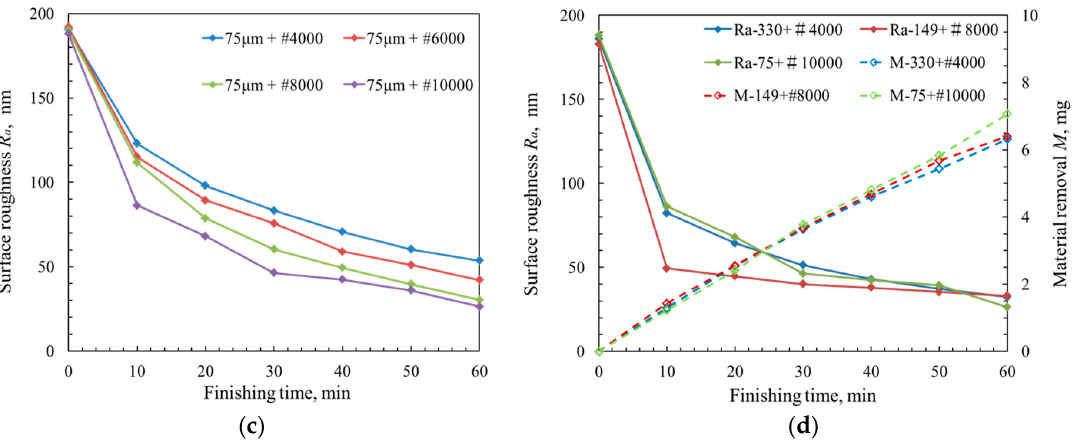
Figure 5. Change in surface roughness R a under the conditions of iron powder with different diameters mixed with different sizes of WA abrasive; comparison of the best experimental results under the conditions of iron powder with different diameters: ( a ) iron powder with a mean diameter of 330 μ m mixed with different sizes of abrasive grains; ( b ) iron powder with a mean diameter of 149 μ m mixed with different sizes of abrasive grains; ( c ) iron powder with a mean diameter of 75 μ m mixed with different sizes of abrasive grains; ( d ) comparison of best experimental results under different diameters of iron powder.